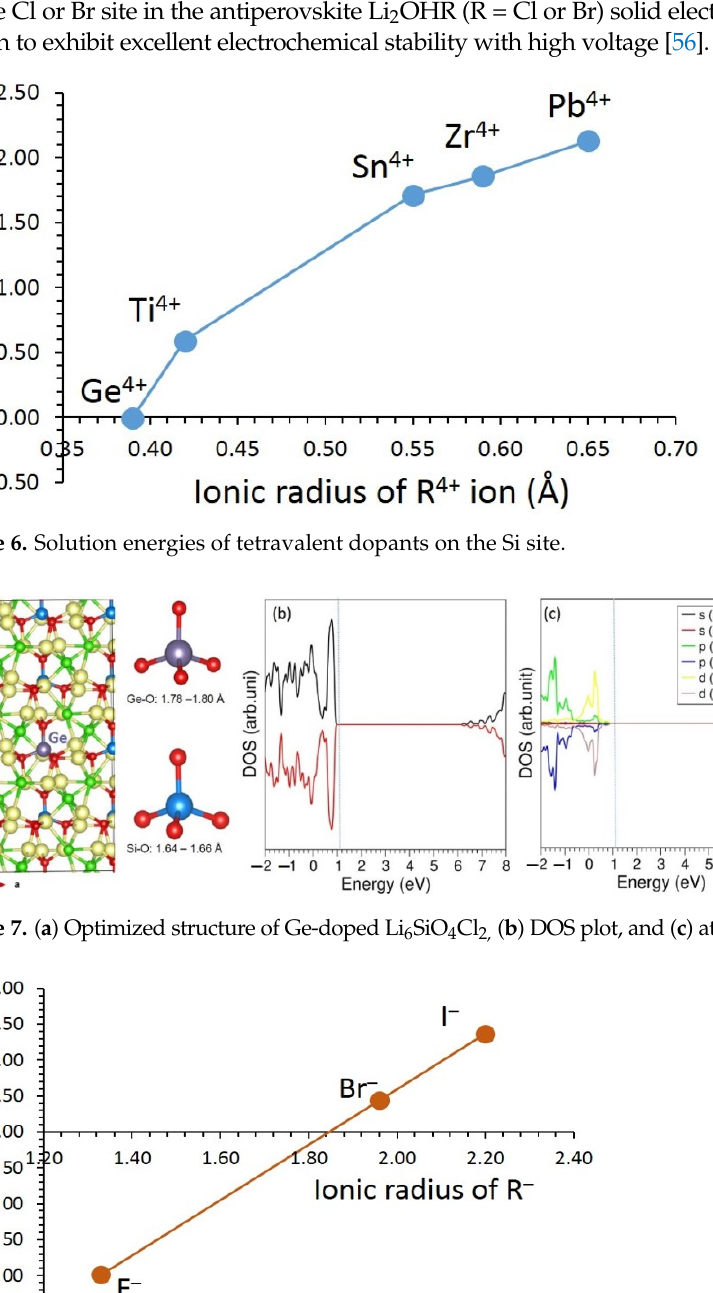
Figure 8. Calculated solution energies of halogen dopants on the Cl site.